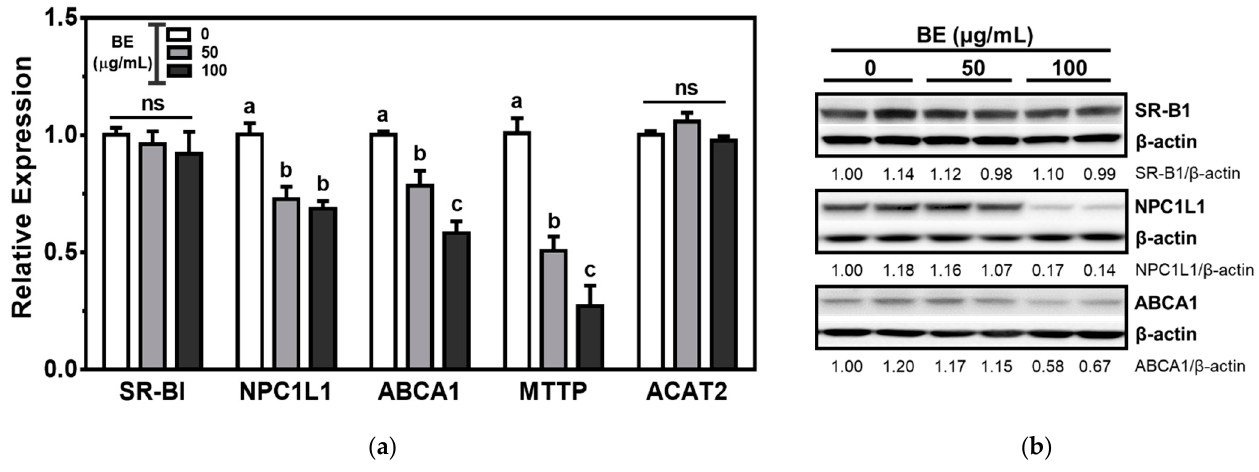
Figure 2. The genes involved in the intestinal cholesterol absorption in BE-treated Caco-2 cells. Cells were treated with 50 or 100 µ g/mL of BE for 24 h. ( a ) The mRNA expression was measured by qRT-PCR analysis. Data are expressed as relative expressions to control. Bars with different letters are significantly different ( p < 0.05), and ns indicates non- significance ( p > 0.05). Values are means ± S.E.M. n = 6. ( b ) The Western blot was conducted twice, and the representative image is shown. β -actin was used as a loading control. Densitometry analysis was performed to measure the relative intensity, and the values are shown under each